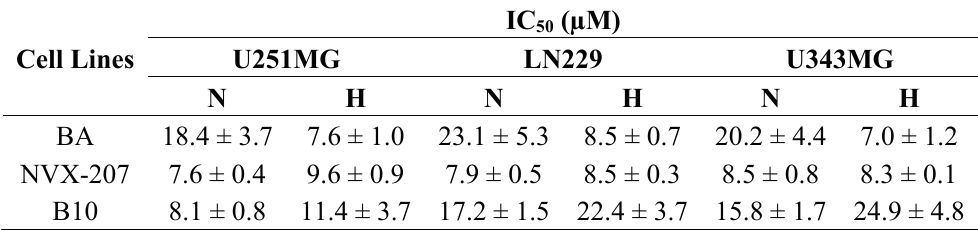
Table 1. IC 50 values of BA, NVX-207 and B10 for glioma cell lines, determined using the SRB-assay.